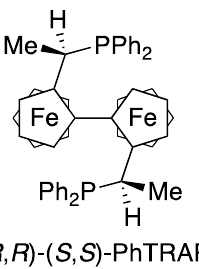
Figure 1. Structure of ( R , R )-( S , S